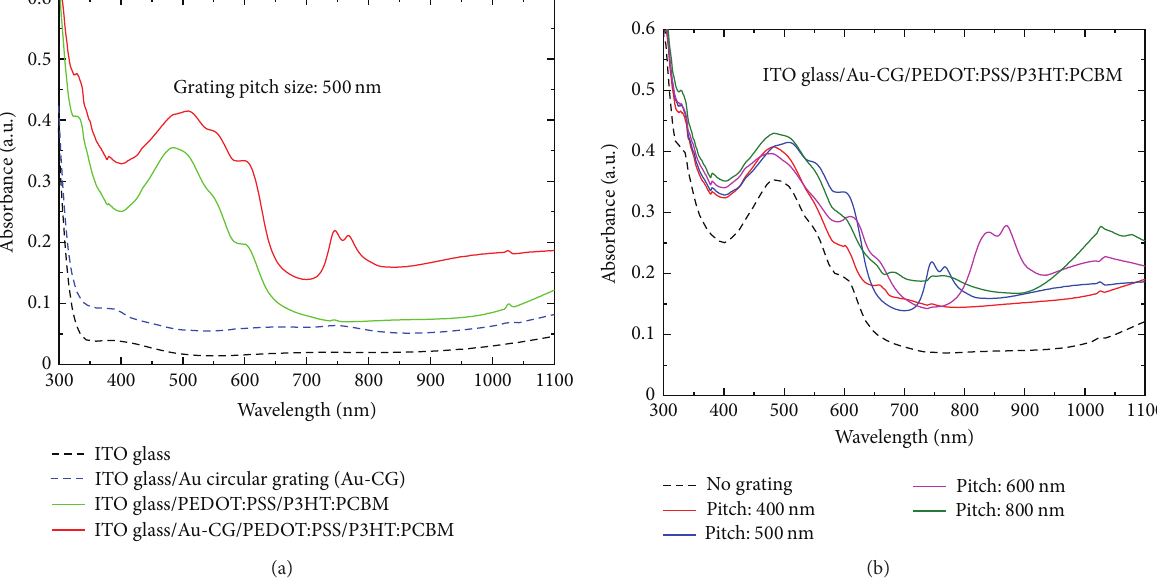
Figure5:(a)Measuredabsorptionenhancementfororganicmaterials(PEDOT:PSS/P3HT:PCBM)onperiodicPCNstructureincomparison with a planar device. (b) Measured absorption enhancement for organic materials (PEDOT:PSS/P3HT:PCBM) on a periodic PCN structure with various grating pitch